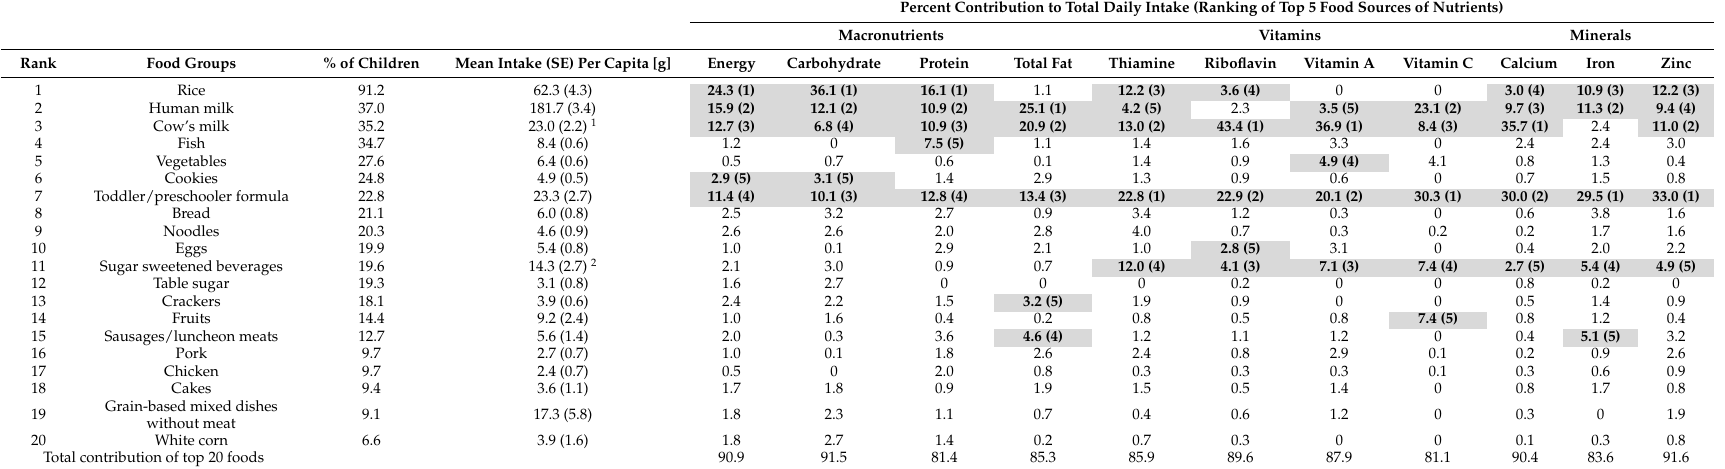
Table 6. Top-20 most consumed food groups and their contribution to energy and selected nutrient intakes among toddlers aged 12–23 months ( n = 714) in the